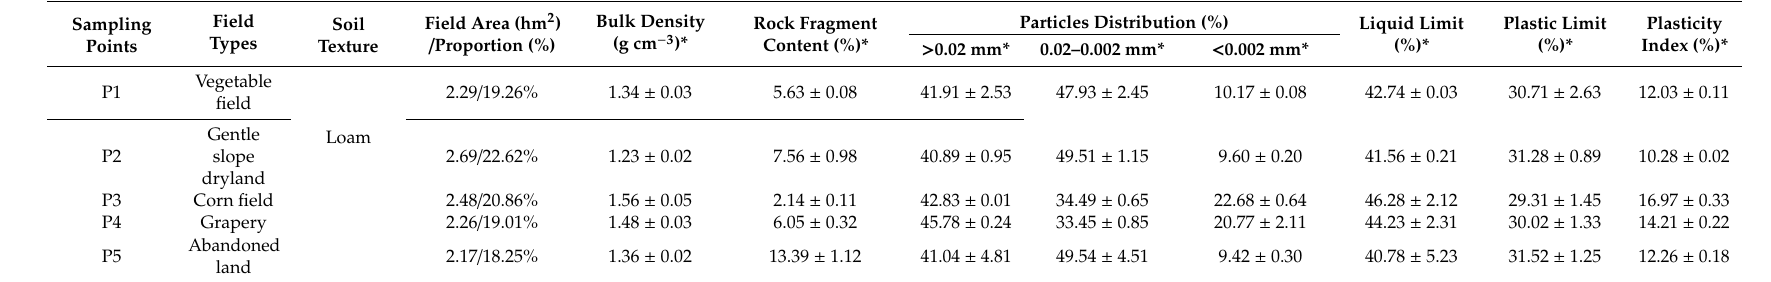
Table 1. The physical properties of the test soils at di ff erent sample